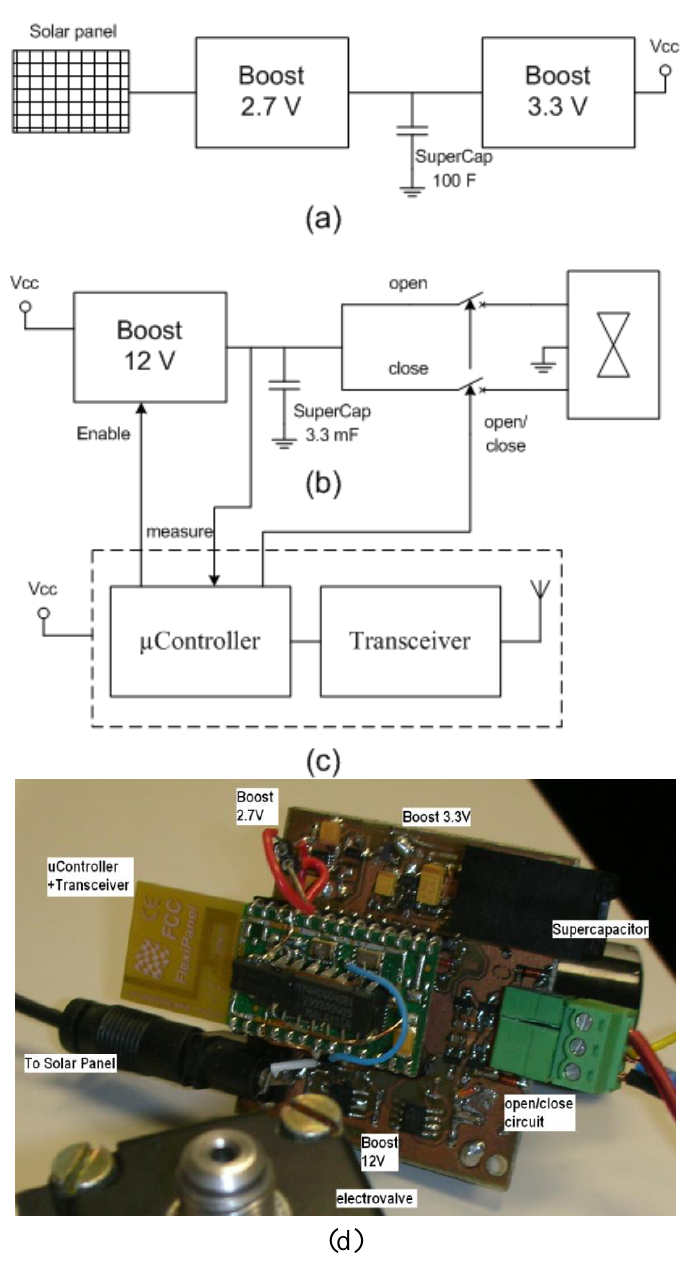
Figure 1. Block diagram of a terminal node. (a) Power circuit formed by the solar panel, a supercapacitor and two highly efficient DC-DC converters; (b) Control circuit of the electrovalve formed by a DC-DC converter, a supercapacitor and a discharge circuit to control the electrovalve; (c) Microcontroller and tranceiver block diagram with a Flexipanel Pixie module; (d) A photo of the wEcoValve laboratory